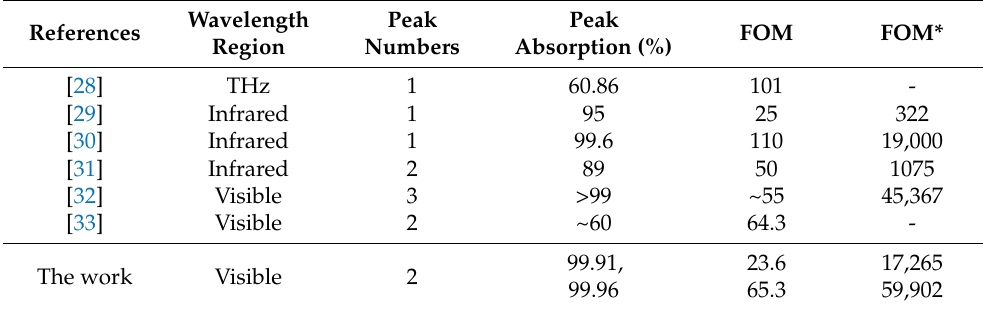
Table 1. Comparison of the proposed absorber with the published refractive index